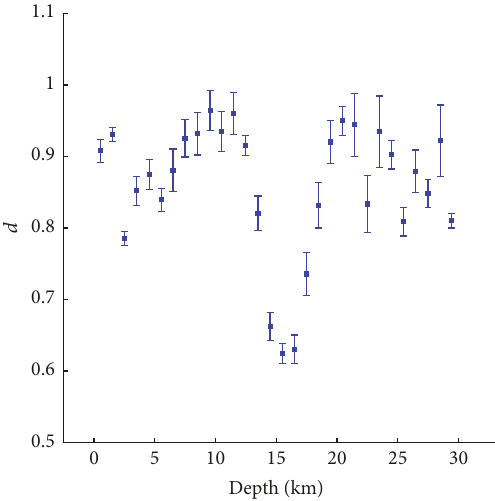
Figure 6: Variation with the depth of 𝑑 , calculated by the modified DFA for the time series of hypocenter separation distance in SC catalog relocated by Richards-Dinger and